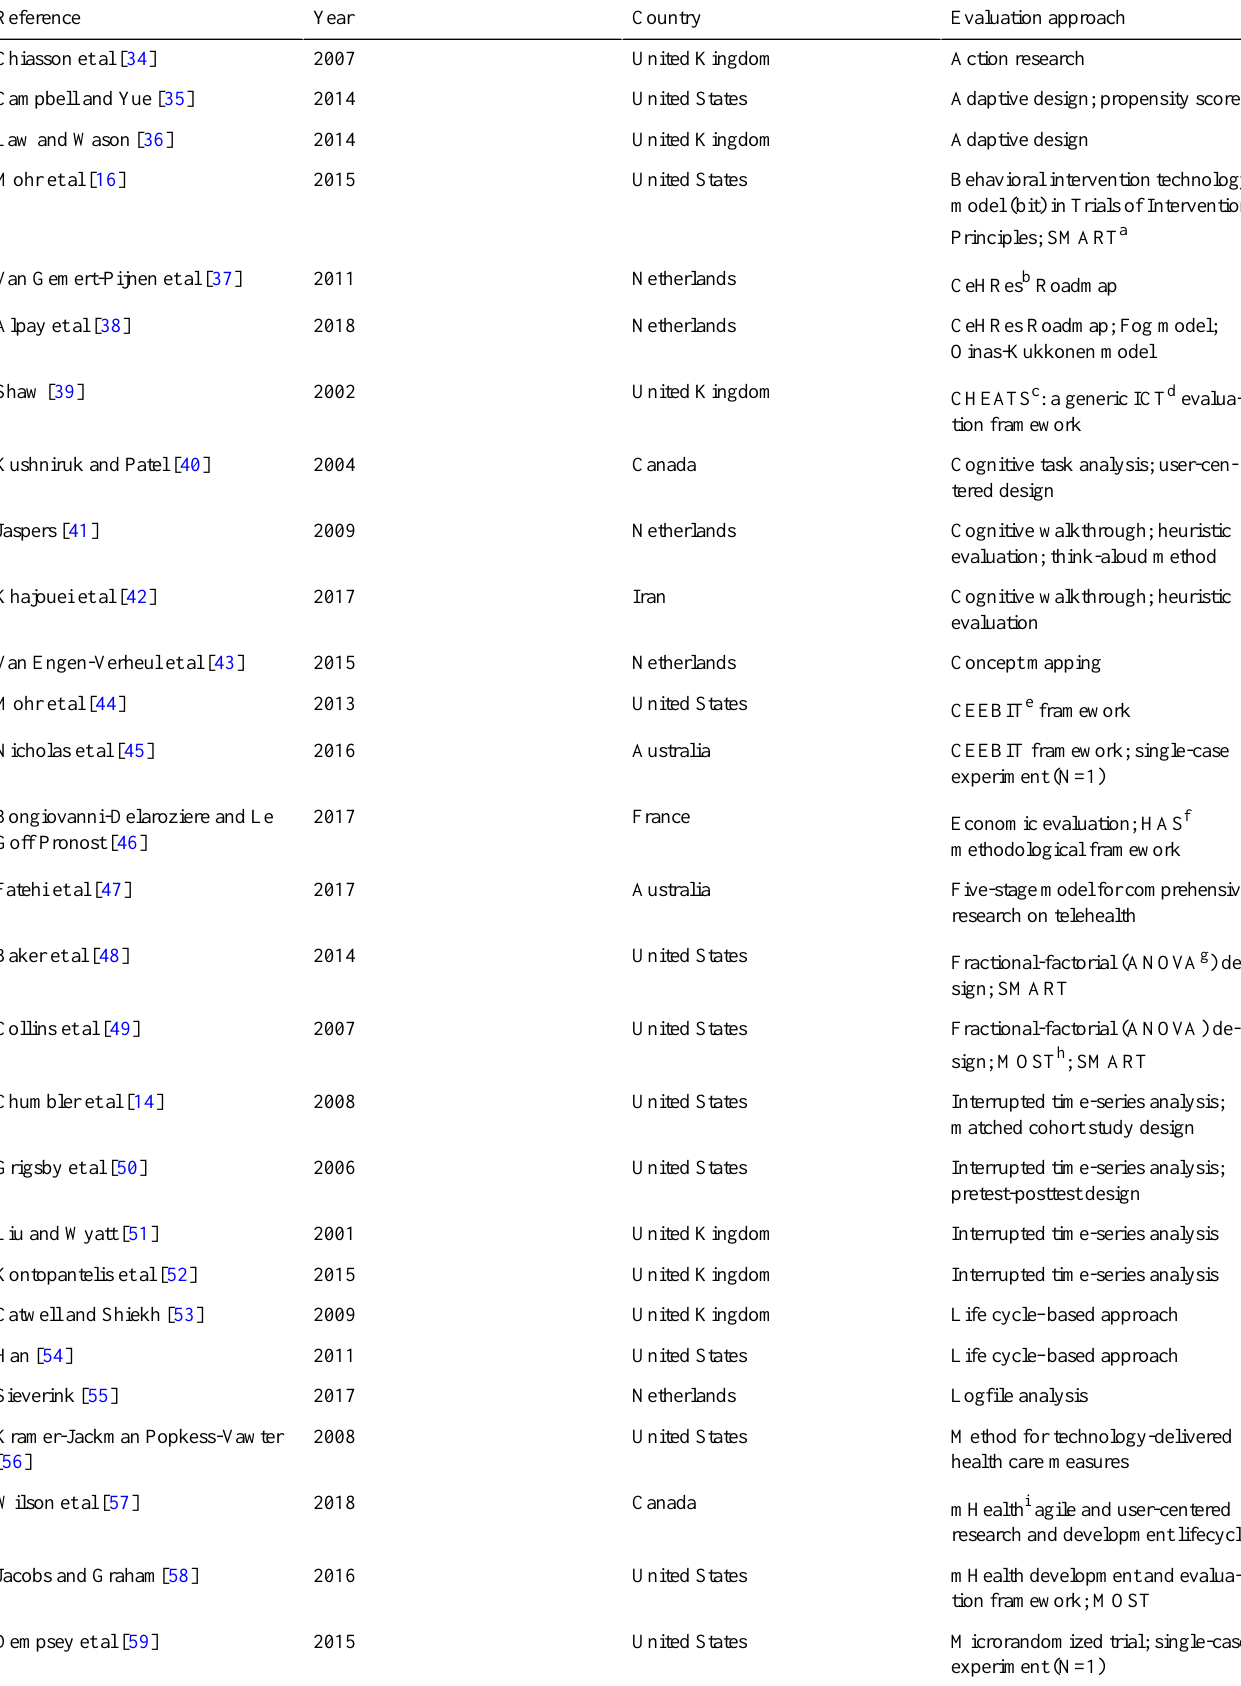
Table 1. Articles included in the systematic scoping review according to the evaluation approach